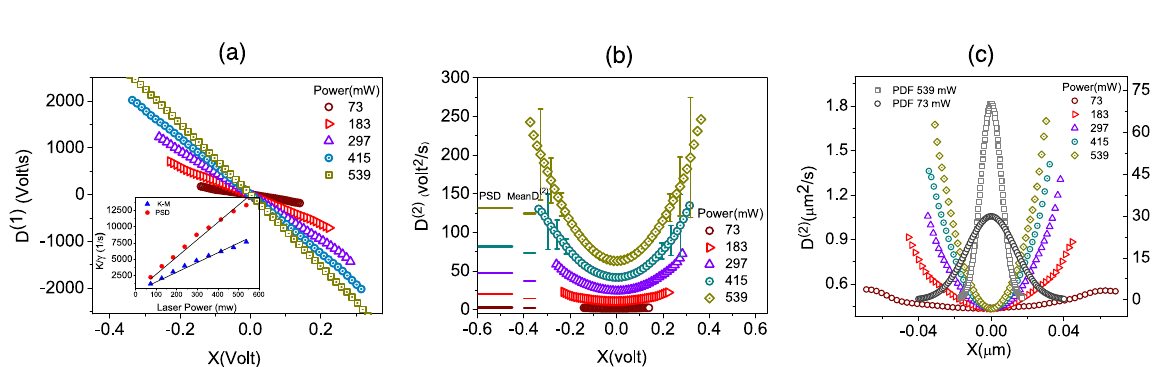
Figure 7. The Markov-Einstein time scale. Estimation of the Markov-Einstein time scale using a χ 2 test, Eq.(10). The laser power dependence of the time scale is plotted in the inset that scales with the laser intensity I as ~ I − 0.9 .